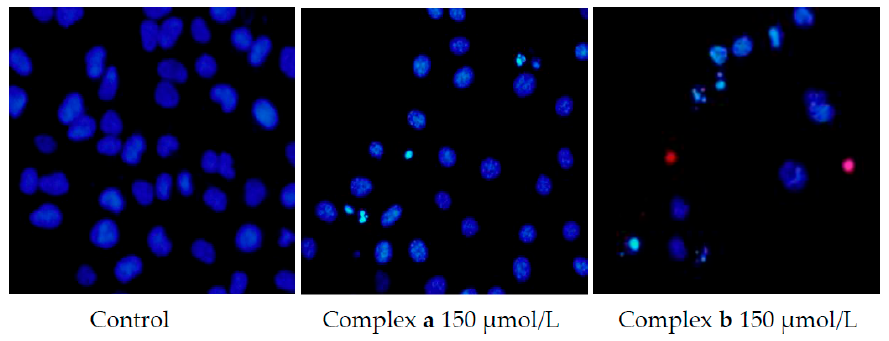
Figure 5. Apoptosis of A549 cell lines induced by complexes a / b .